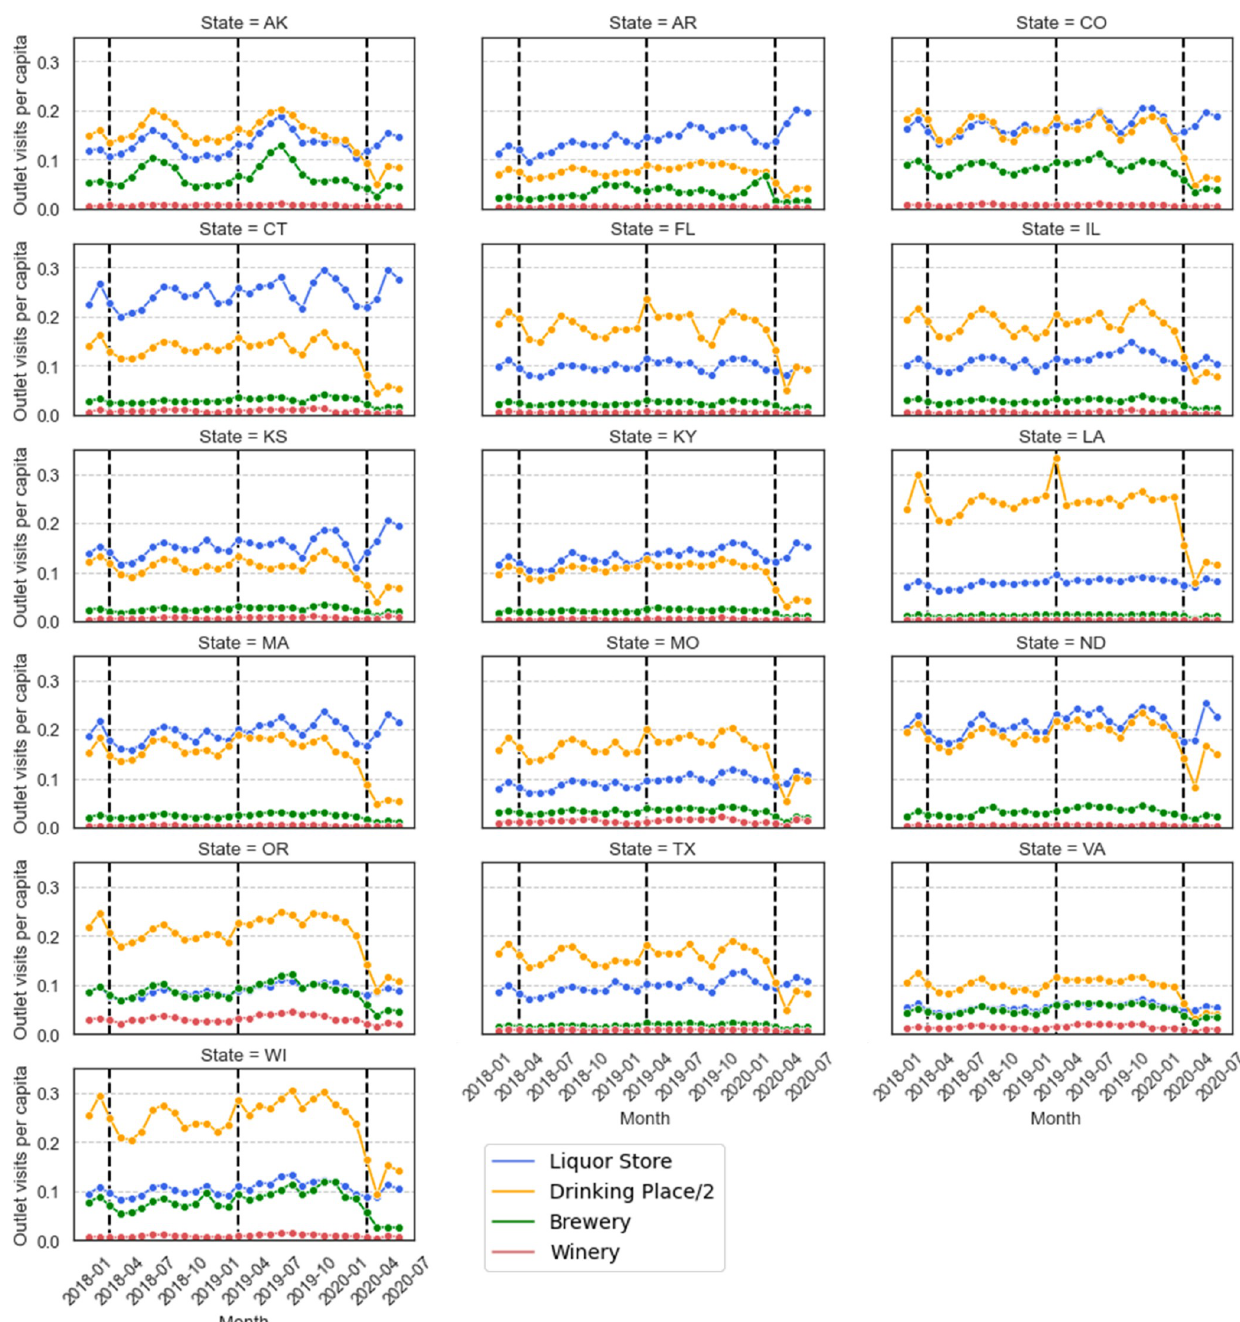
Fig 10. Visits to the four types of alcohol outlets in each of the 16 states. The vertical dashed lines indicate the month of March in 2018, 2019, and